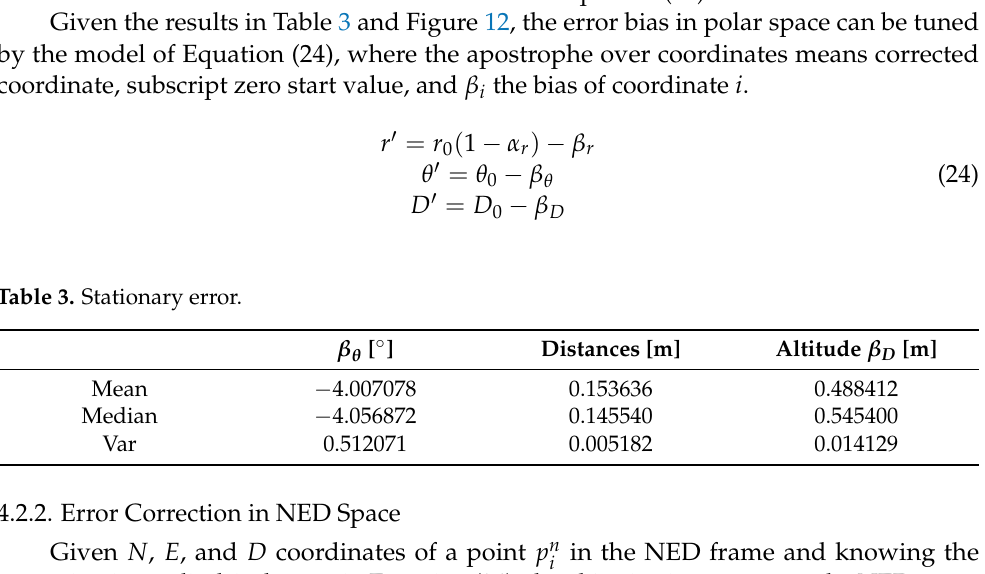
Table 3. Stationary error.